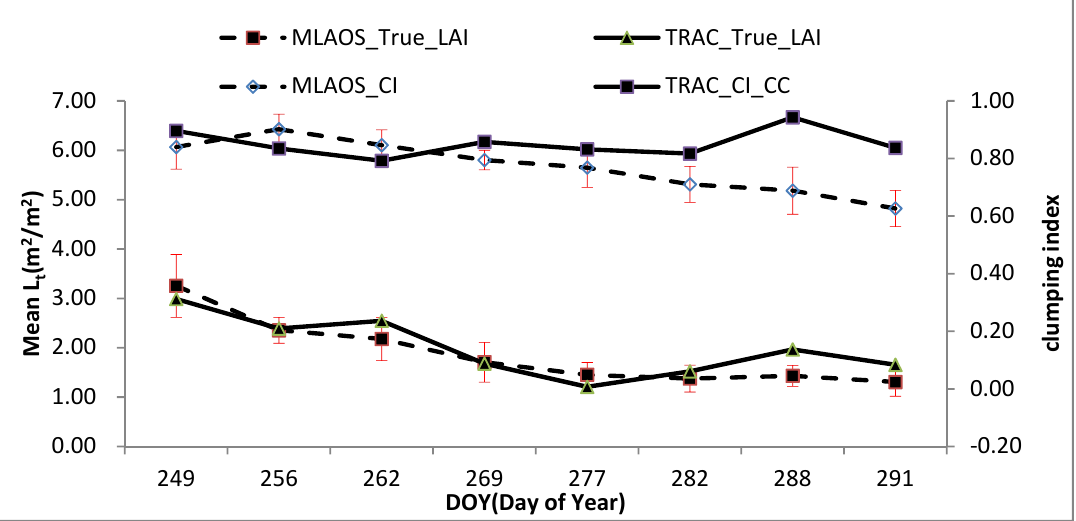
Figure 8. The LAI (left axes) and CI (right axes) of MLAOS and TRAC at a temporal sequence after being aggregated. The standard deviation values of MLAOS also are shown in red